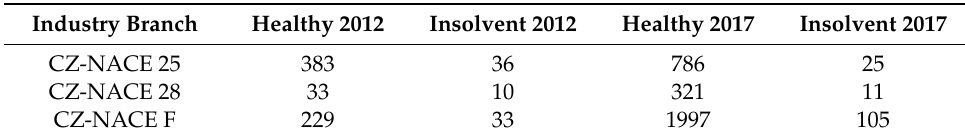
Table 1. Size of the analyzed